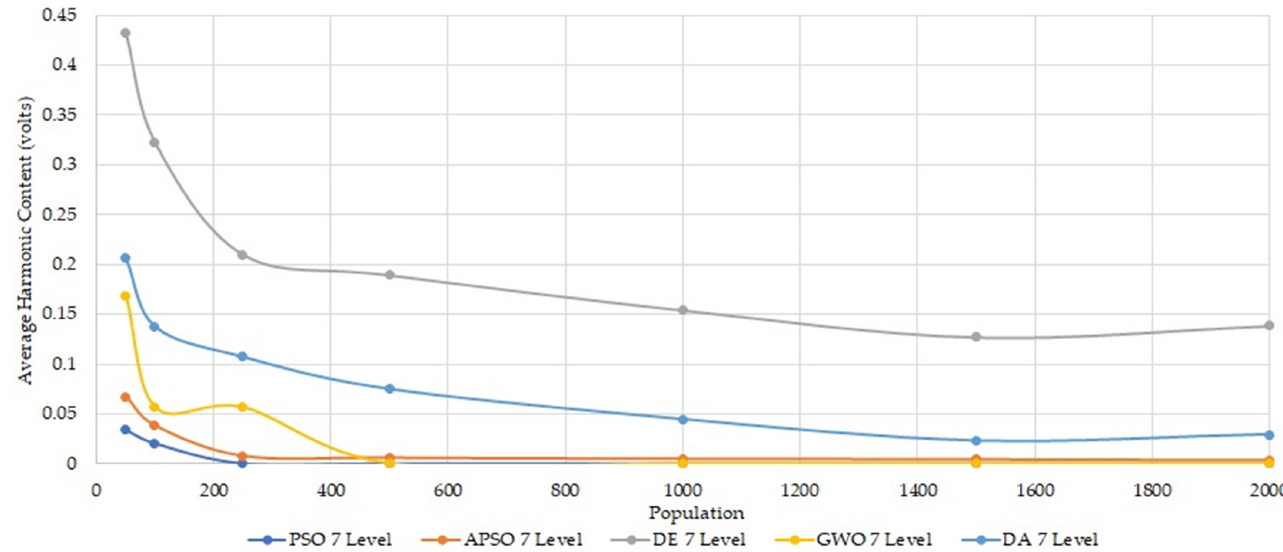
Figure 10. Algorithms’ average performance for a seven-level inverter.